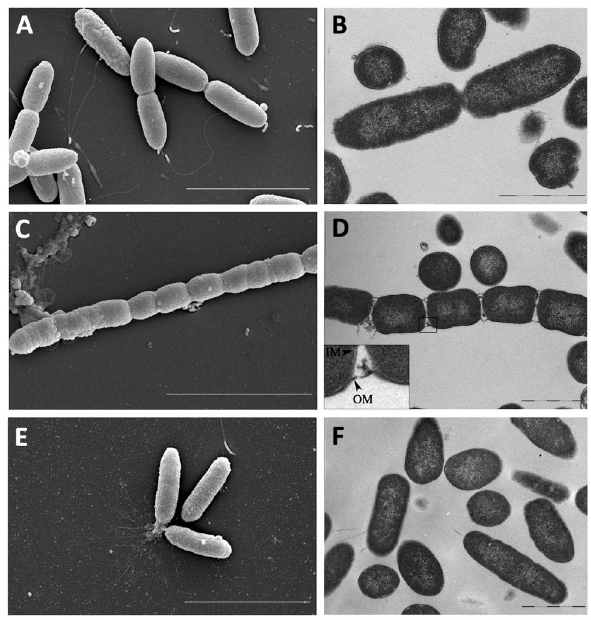
Figure 4. TolB-deficient cells show defects in outer membrane stability and cell division. SEM and TEM analysis (left and right panels, respectively) of PAO1 wild-type cells (A,B), TolB-deficient mutant cells (C,D) and TolB-proficient mutant cells (E,F), grown as described in the legend to Fig. 3A. Bars: 3 m m (left panels) or 1 m m (right panels). The inset in panel D shows an enlargement of the boxed area. Abbreviations: IM, inner membrane; OM, outer membrane.